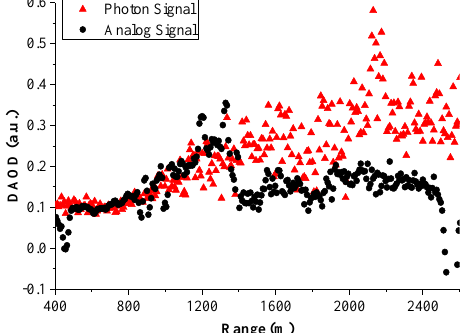
Figure 3. DAOD value calculated from AD and PC signals.